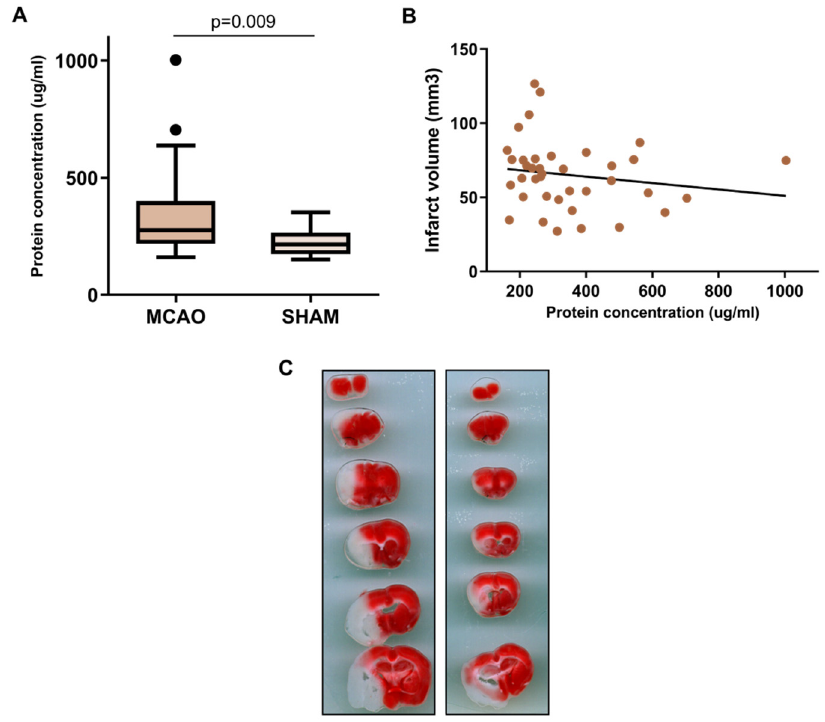
Figure 1. Evaluation of the protein concentration in BALF. ( A ) Boxplot comparing the BALF protein concentration between ischemic and sham mice (N = 53) ( B ) Scatter plot representing the BALF protein concentration ( X axis) and the infarct volume ( Y axis) of the ischemic animals (N = 42). ( C ) Two representative images of cerebral ischemia measured by TTC staining. The boxplot in ( A ) shows increased protein concentration in MCAO animals compared to sham , while the scatterplot in B showed the lack of correlation between infarct volume and protein concentration. MCAO: middle cerebral artery occlusion.